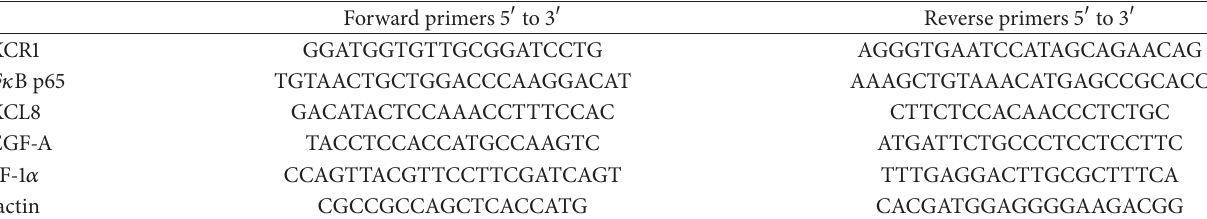
Table 1: List of primers used in this study for